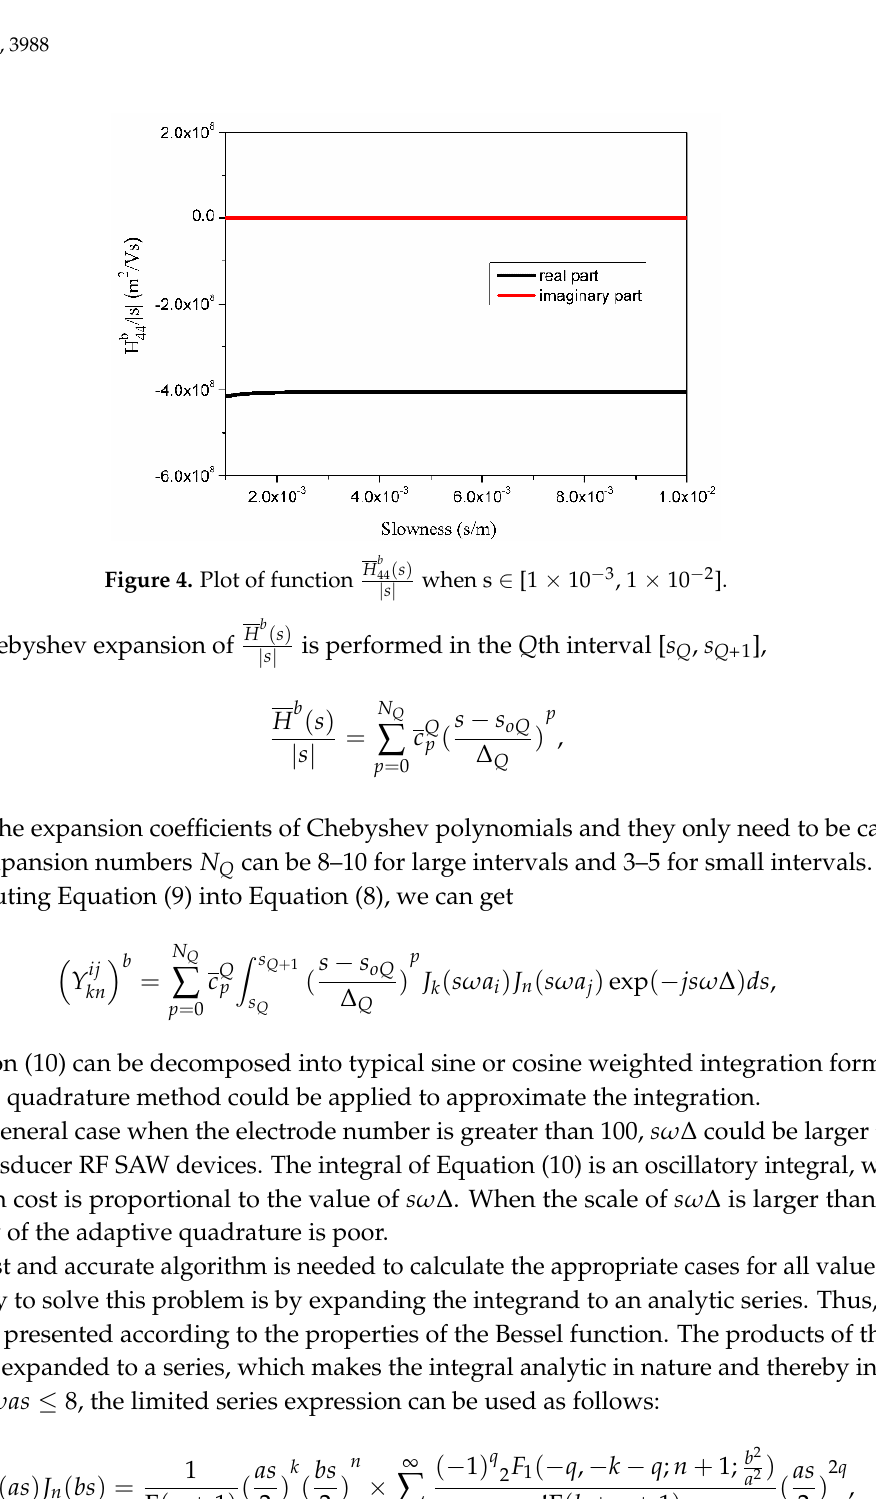
Figure 3. Plot of function